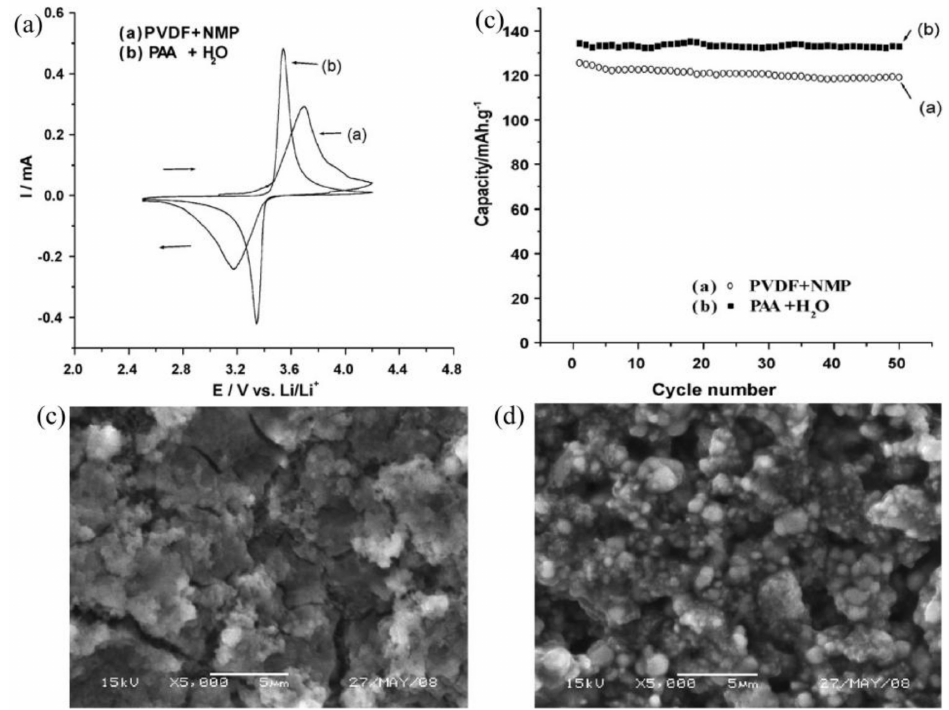
Figure 3. ( a ) Cyclic voltammograms of LiFePO 4 electrodes in 1-M LiPF 6 /EC:DMC:EMC (volume ratio 1:1:1), scan rate: 0.1 mV s − 1 . SEM images of LiFePO4 electrodes. ( b ) Cyclic stability of LiFePO 4 electrodes in 1-M LiPF 6 /EC:DMC:EMC (volume ratio = 1:1:1). ( c ) The electrode was prepared in NMP with PVDF as a binder and ( d ) the electrode was prepared in the aqueous solvent with PAA as a binder. Reprinted with permission from ref. [49]. Copyright 2009